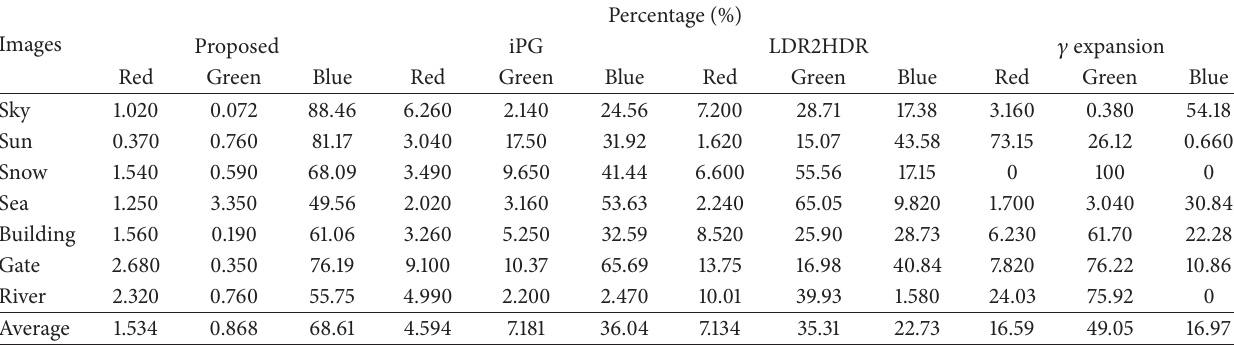
Table 1: Red, green, and blue percentages of metric result for subset images: large red percentage means more contrast reversal, large green percentage denotes more contrast loss, and large blue percentage indicates more detail revelation.